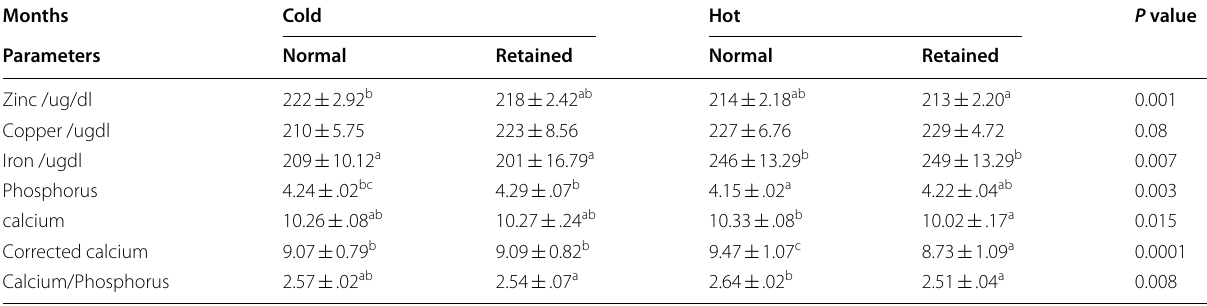
Means with different superscripts (a, b, c,) are significant at P < 0.05